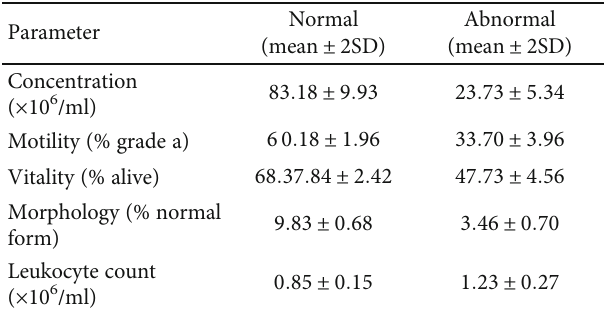
Table 1: Values of standard parameters of normal and abnormal samples by WHO ∗